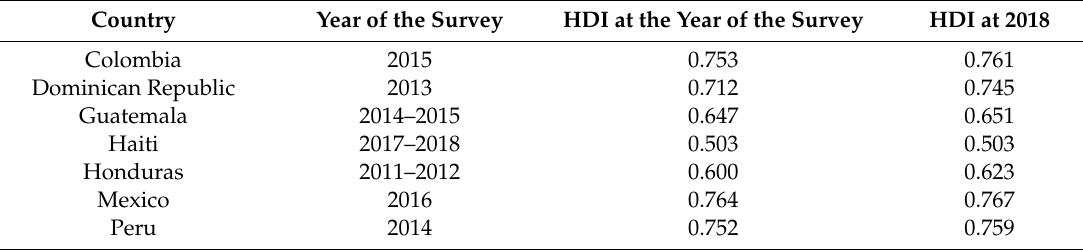
Table 3. Human Development Index (HDI) for the evaluated countries, both for the year of the survey and for 2018.